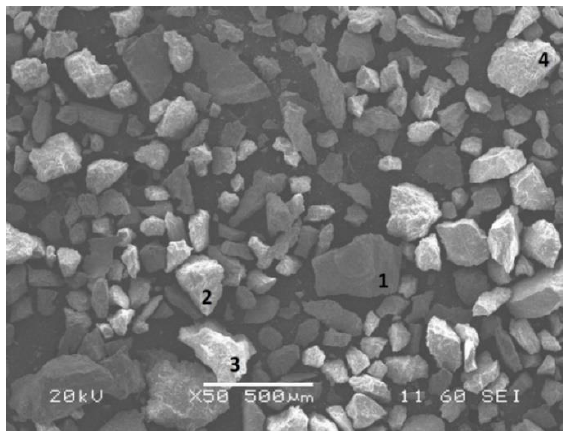
Figure 2. Scanning electron microscopy (SEM) image (×50) of the feed sample. Particles identified: copper pitch (1); chrysocolla (2); dioptase (3); and potassium feldspar (4).